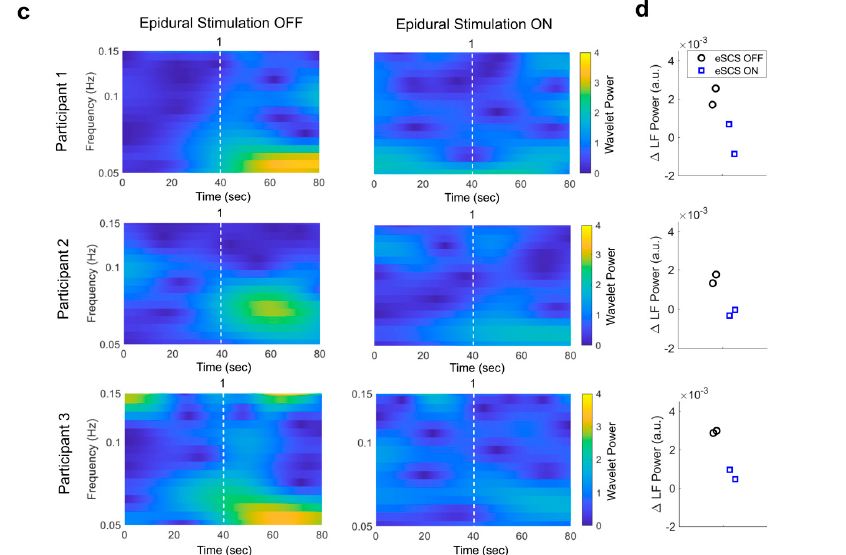
Figure 2. Effect of eSCS on AD during DARS in three individuals with SCI. ( a ) Cardiovascular responses during DARS with eSCS OFF (grey shading) and eSCS ON (blue shading). The first vertical black dotted line (1) shows the start of DARS (i.e., insertion of index finger into the rectum), and the second vertical black dotted line (2) shows the completion of DARS (i.e., removal of finger). ( b ) Changes in SBP, DBP and HR during DARS with (blue symbols) and without (black symbols) eSCS in each participant. During DARS without eSCS, all participants showed an elevation in SBP greater than the 20-mmHg threshold for AD diagnosis (gray dotted lines). However, DARS with eSCS consistently reduced changes in SBP, keeping it below the threshold for AD diagnosis (grey dotted lines). ( c ) Scalogram showing wavelet power (yellow color) at low frequencies (0.05–0.15 Hz, y -axis) over time ( x -axis). Wavelet power scalogram shows increased low frequency power during DARS without eSCS. However, with eSCS, all participants showed a decrease in wavelet power following the start of DARS (white dotted vertical line 1). ( d ) The elevation in low frequency power following DARS was prevented with eSCS ON compared to eSCS OFF in all participants. Abbreviations: a.u., arbitrary unit; BPM, beats per minute; DARS, digital anorectal stimulation; DBP, diastolic blood pressure; eSCS, epidural spinal cord stimulation; HR, heart rate; Hz, hertz; LF, low frequency; mmHg, millimeter of mercury; SBP, systolic blood pressure; ∆ ,